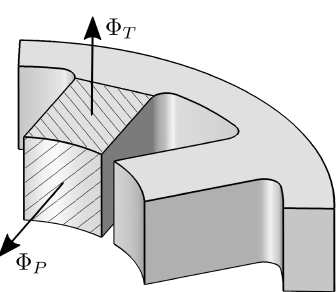
Figure 9. One quarter of the stator of the radial 8-poles radial actuator: Φ T is the magnetic flux straying through the top face of one polar expansion; Φ P is the magnetic flux flowing through the polar area.